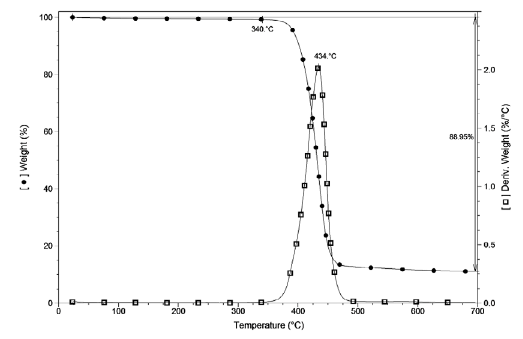
Figure 5. TG and DTG curves for the PET samples. waste (untreated or treated) into the processed polymer matrix on melting and crystallization temperatures (T T ), and degree of crystallinity were observed and analyzed c (Table 6). The T peaks of the all processed polymeric m composites are slightly lower or higher than observed